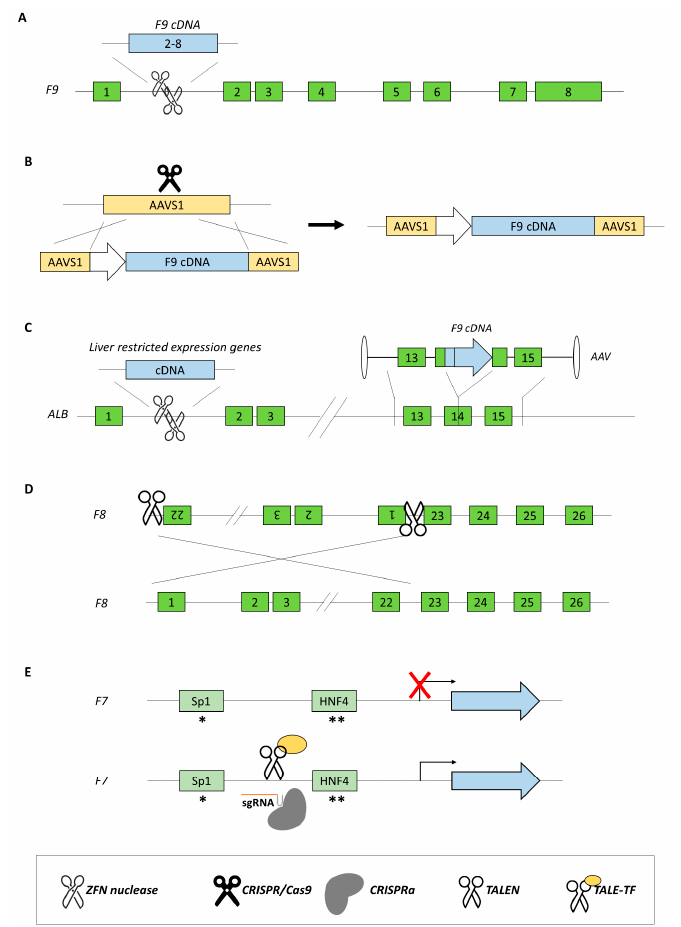
Figure 3. Gene editing and transcription modulation-based approaches for coagulation factor deficiencies. Approaches aimed at correcting and / or modulating the expression of coagulation factor genes through ZFNs ( A ), cleavage by CRISPR / Cas9 ( B ), engineering of the albumin locus to drive F9 gene expression ( C ), correction of intron 22 inversion in F8 gene ( D ), and TALE-TF or the CRISPRa systems leading to an increase in luciferase (reporter constructs) or endogenous activity due to F7 promoter transactivation ( E ). Asterisks represent the c.-94C > G (*) and c.-61T > G (**) nucleotide